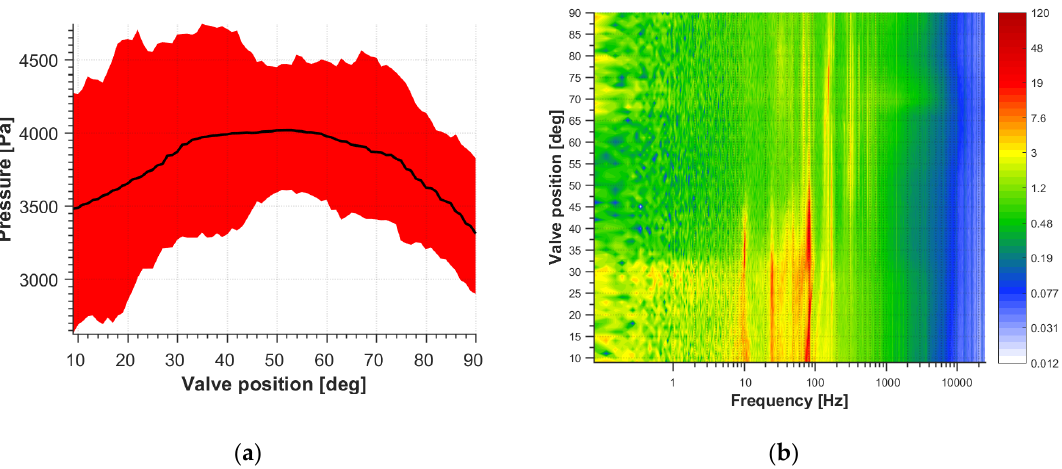
Figure 7. Pressure variation depending on the valve position measured at the diffuser at impeller rotational speed 95 Hz. ( a ) The left plot represents the min-to-max plot (red) and the pressure average value (black). ( b ) The right plot represents the spectral map with the colormap in the logarithmic scale.